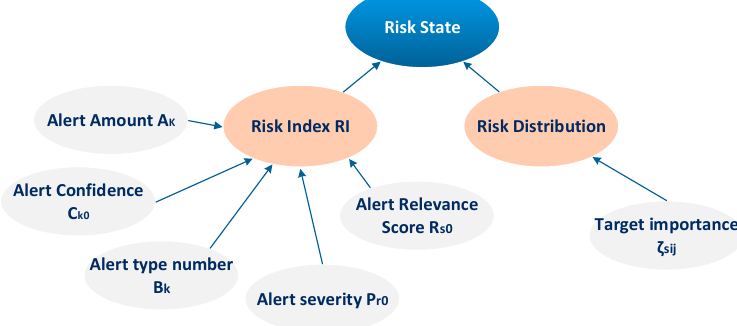
Figure 5. Online risk assessment model proposed by Mu et al. [38].